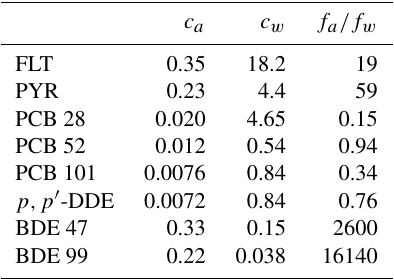
Table 2. Concentrations in air (gaseous, ground level, z = 1 . 05m, if > LOQ for most samples; ngm − 3 , except PBDEs: pgm − 3 ) and surface seawater (pgL − 1 ) and fugacity ratios, f a /f w